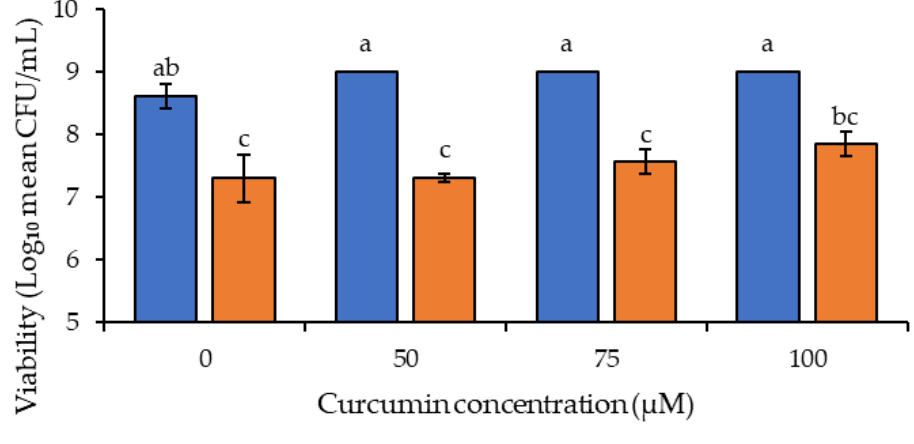
Figure 2. Effect of photosensitization on the viability of Aspergillus flavus on peanuts treated in 50, 75 and 100 µ M of curcumin using a light dosage of 114.5 J/cm 2 . Different letters indicate statistically significant differences ( p < 0.05) between treatments; n = 3 independent experiments with triplicate samples per condition per experiment.